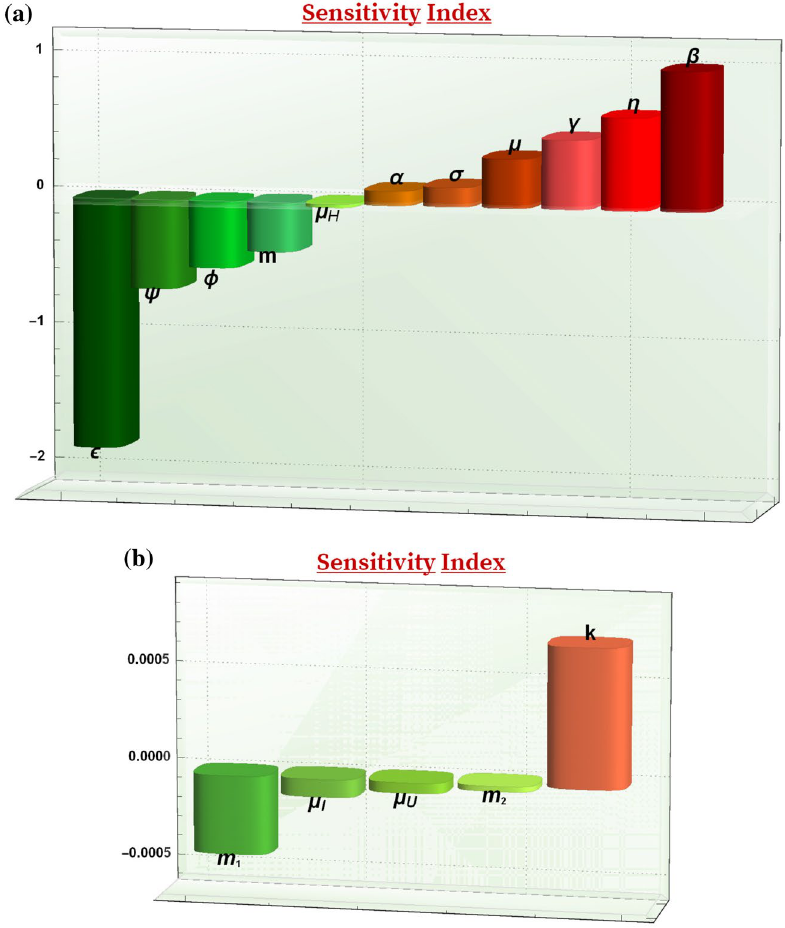
Figure 2. Graphs showing the sensitivity of the reproduction number with respect to all the